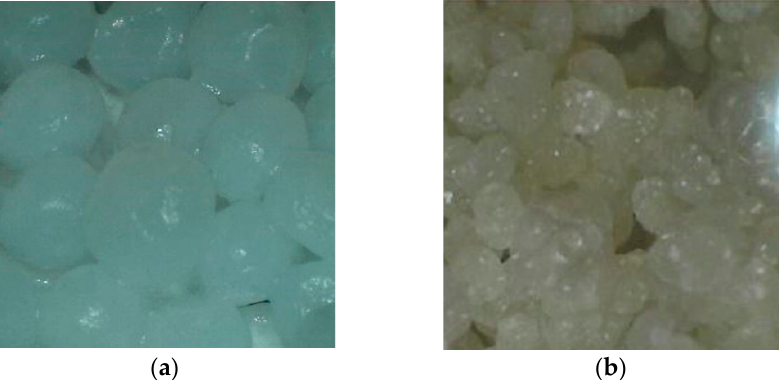
Figure 4. Photograph with a digital microscope: ( a ) wet Al@10(E)-O-10(E) Cl; ( b ) dry Al@10(E)-O-10(E) Cl.